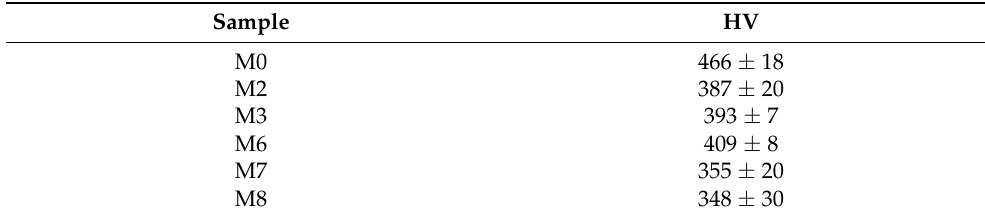
Table 7. Vickers hardness of the adjacent zone to the textured